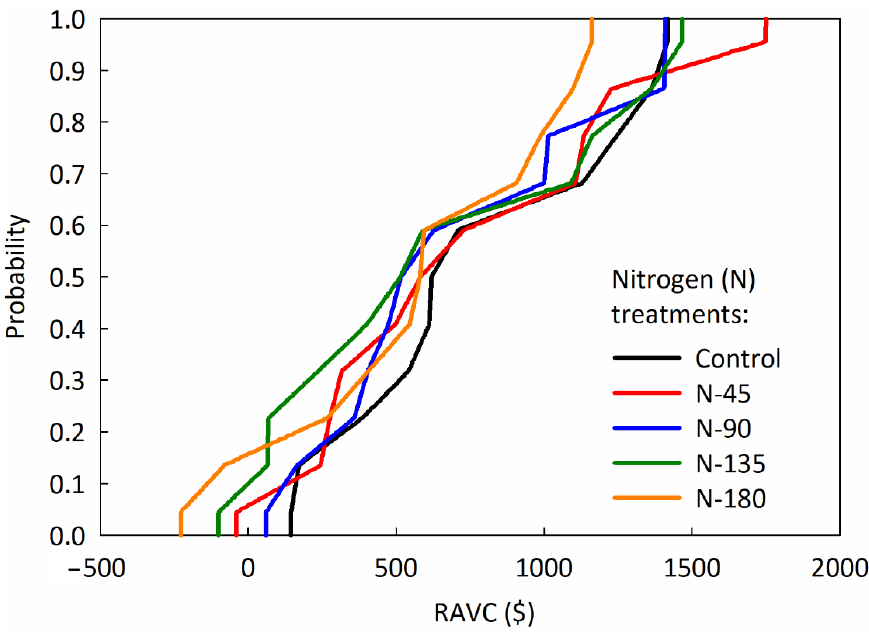
Figure 4. A Cumulative Distribution Function (CDF) comparing returns above variable cost across various N rates for FM 958.